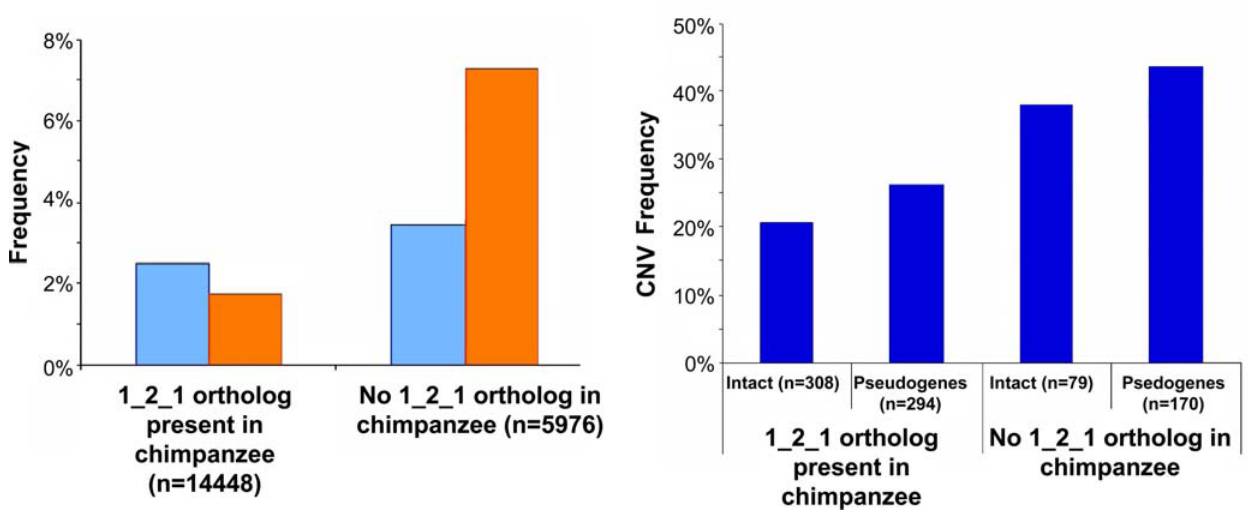
Figure 4. CNVs preferentially affect ORs lacking unambiguous one-to-one orthologs in the chimpanzee genome. A) Gains and losses of OR loci were called using our microarrays (see Methods). Gains are shown in blue; losses in orange; n is the number of total calls considered (24 samples multiplied by the number of genes in each category). OR loci with a one-to-one (‘‘1-2-1’’) ortholog in the chimpanzee genome are significantly (P value , 0.001; Mann-Whitney U test) less often affected by CNVs than loci lacking a 1-2-1 ortholog. B) Frequencies of CNV loci are given separately for intact OR genes and pseudogenes in each of the evolutionary classes. ‘‘Frequency’’: relative frequency of being called a CNV for a set.